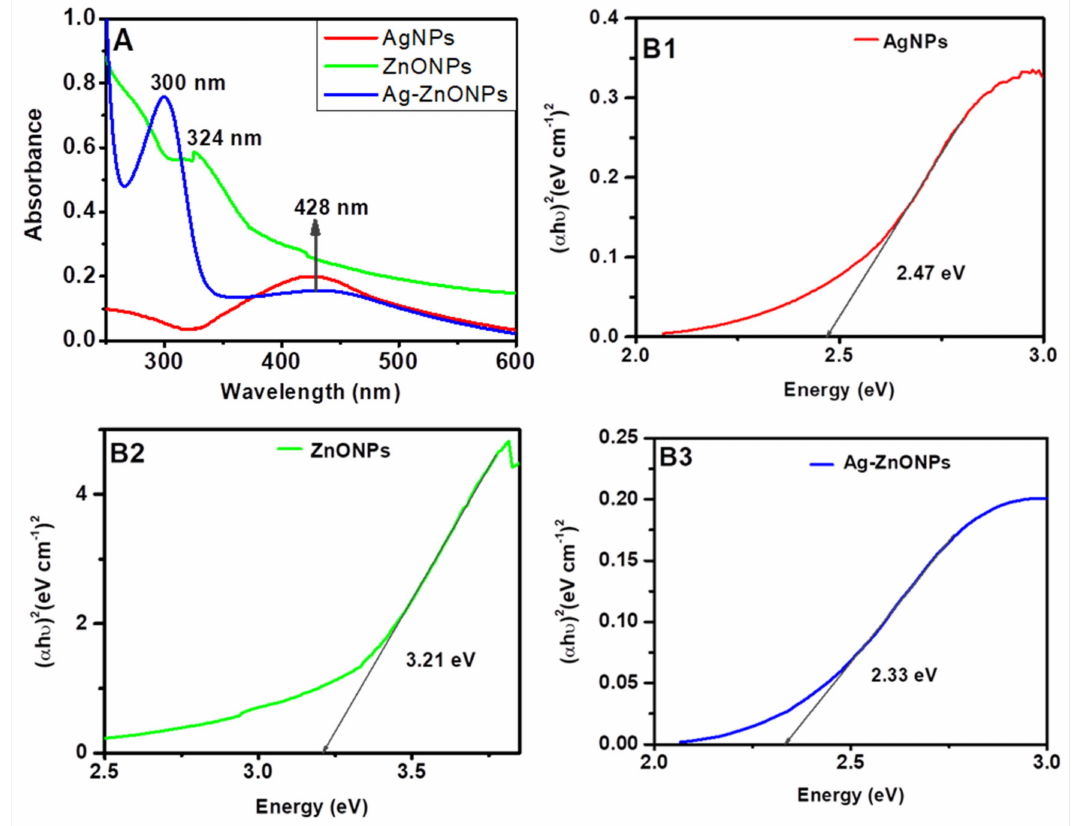
Figure 1. UV-Vis spectra ( A ); and Tauc plots ( B1 – B3 ) of nanomaterials synthesized with leaf extracts of Bidens pilosa and silver and/or zinc nitrate